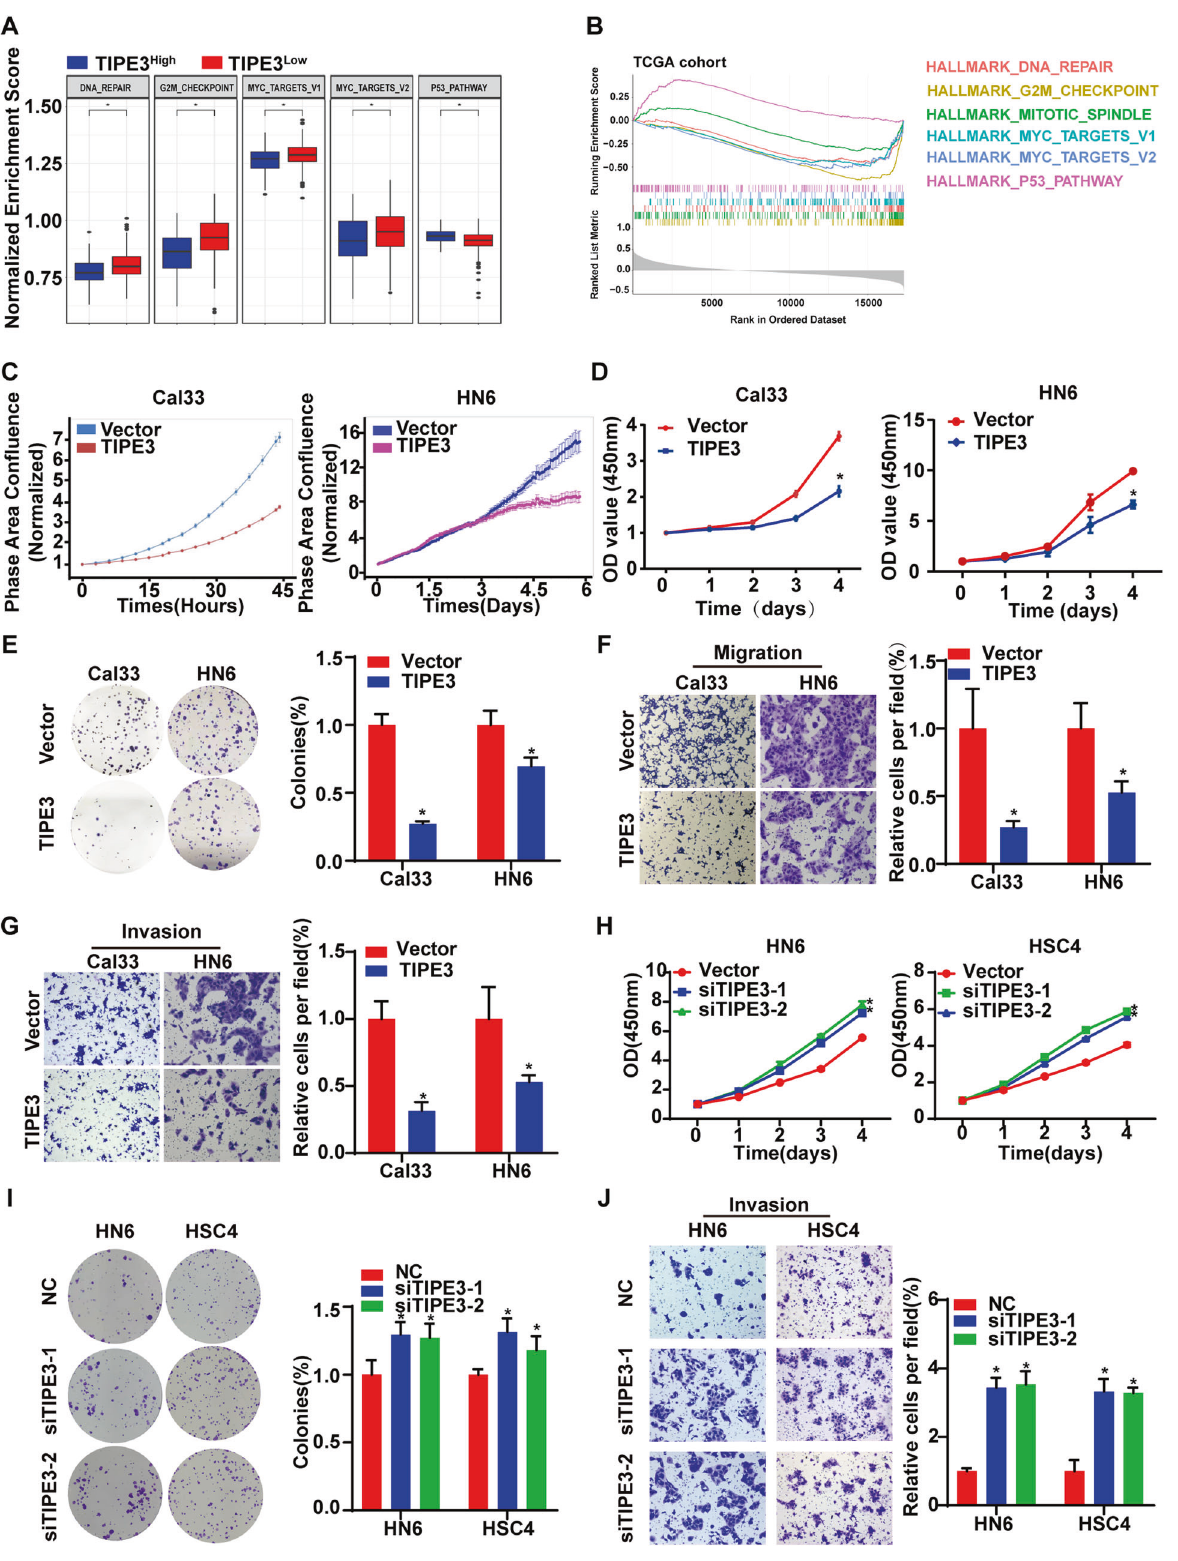
con fi rmed that low TIPE3 mRNA level was associated with high risk of death (Supplementary Fig. 4A). Multivariate Cox regression analysis revealed that TIPE3 was an independent prognostic indicator for OS in HNSCC patients (Supplementary Fig. 4B).